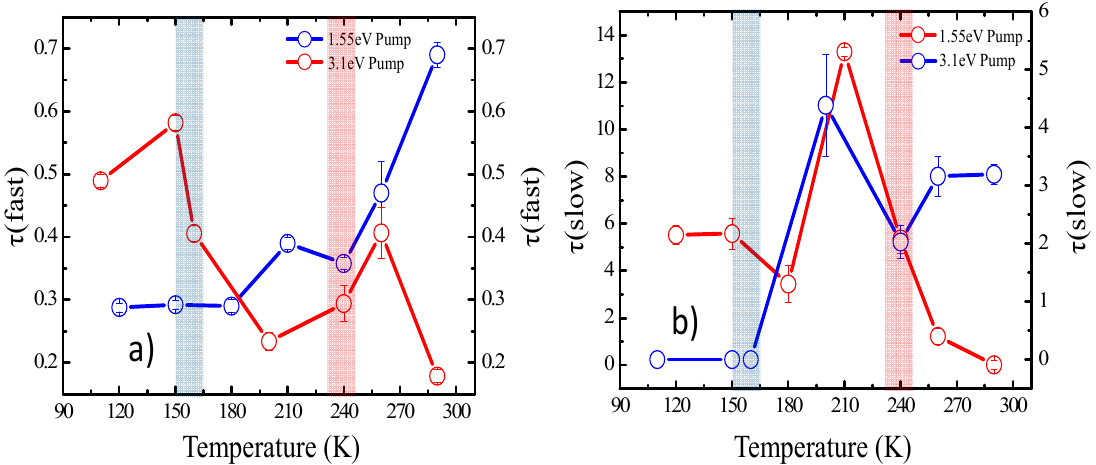
Figure 4. ( a ) The temperature dependence of the fast component τ (fast)(ps) ( τ e − ph ) for di ff erent pump wavelengths; the blue for 3.1 eV and red for 1.55 eV pumps, respectively. ( b ) The temperature dependence of the slow component τ (slow)(ps) ( τ s − ph ) for di ff erent pump wavelengths. Both diagrams have highlighted the two magnetic phase transition ranges for guiding